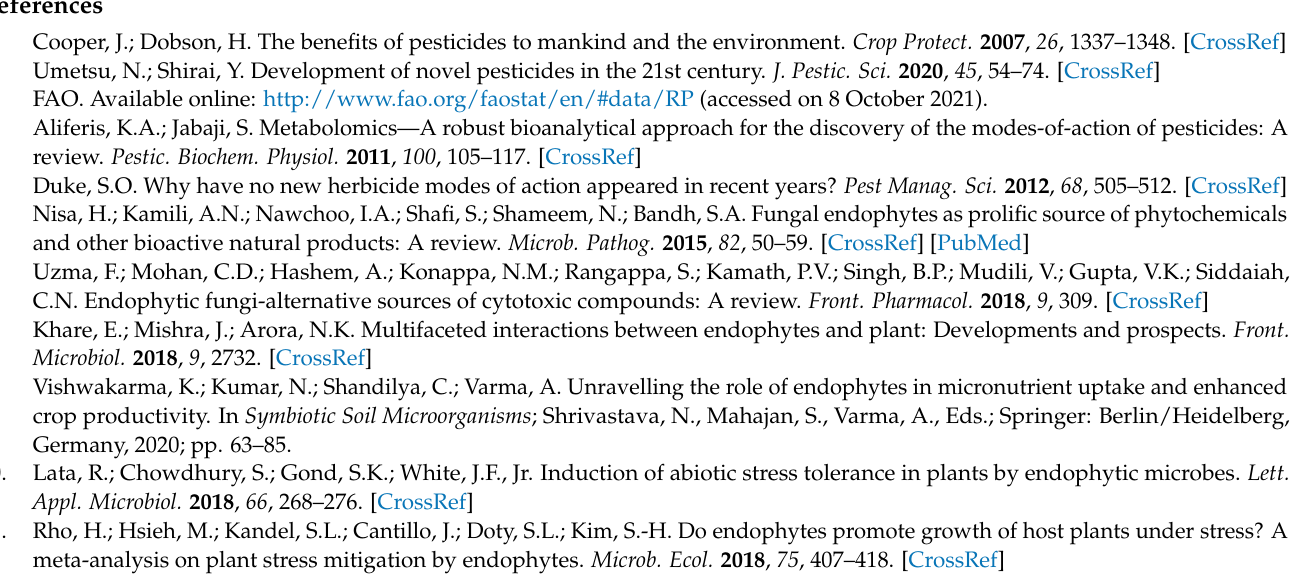
genes, respectively, Figure S3: Bacillus sp. PTA13 growth rate and its lipopeptide-producing capacity in the time-course study, Figure S4: TIC (ESI+) chromatograms of the upper and lower phases of the biphasic solvent systems 12–17, Figure S5: TLC chromatogram displaying the separation between the fengycin and bacillomycin groups produced by the olive tree endophytic Bacillus sp. PTA13 isolate, Figure S6: TIC (ESI+) of the combined CPC fractions displaying the gradual elution of the olive tree endophytic Bacillus sp., Figure S7: Olive tree tissues that were used for the isolation of endophytic microorganisms, Table S1: Biphasic solvent systems that were assessed for the fractionation of the Bacillus sp. PTA13 total lipopeptide (LP) extract, File S1: MS 1 and MS 2 of annotated Bacillus sp. PTA13 lipopeptides. The fragmentation patterns were used for their annotation, Data Set S1: Bacillus -produced